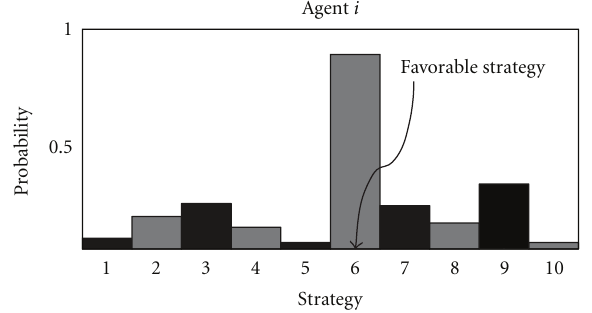
Figure 2: Probability Distribution of agent i